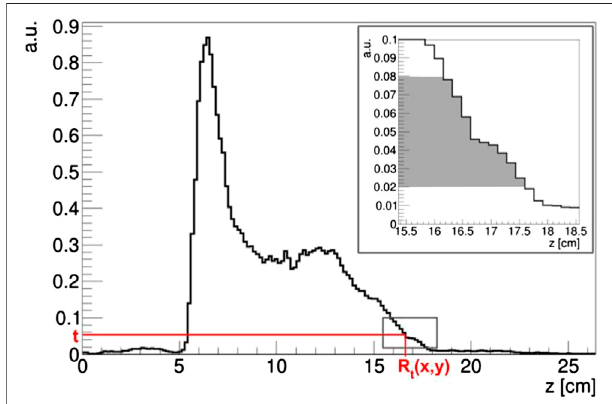
FIGURE 3 | Example of R t ( x , y ) calculation on an activity pro fi le normalizedatthemaximumintensityinthePETimage.Inthebox,therangeof the t threshold used in the proposed analysis is highlighted in